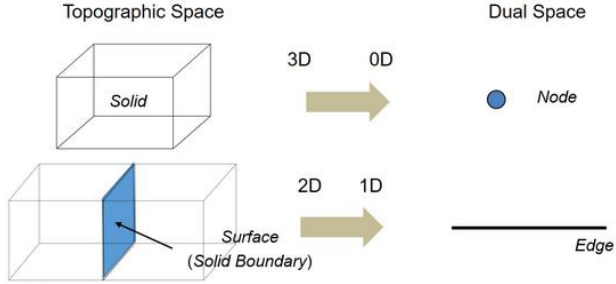
Figure 3. Example of dual transformation [30] .